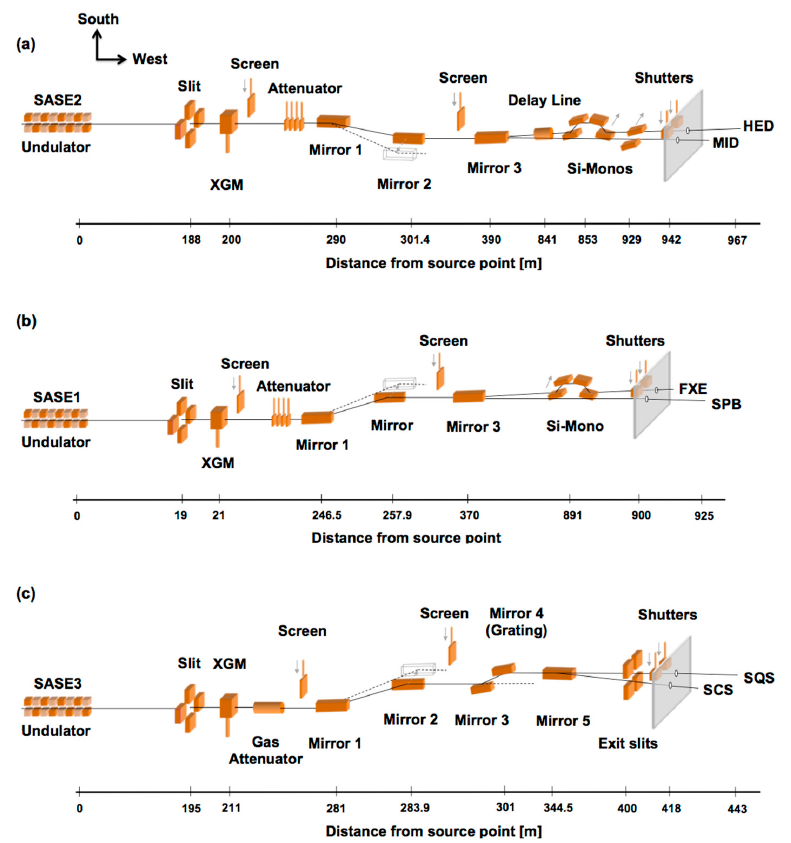
Figure 3. Optical layout of the three photon beam transports with some of the most important elements in the sequence towards the instruments located in the experiment hall. The most southern beam line is: SASE2 ( a ); then SASE1 ( b ); and SASE3 ( c ). is: SASE2 ( a ); then SASE1 ( b ); and SASE3 ( c